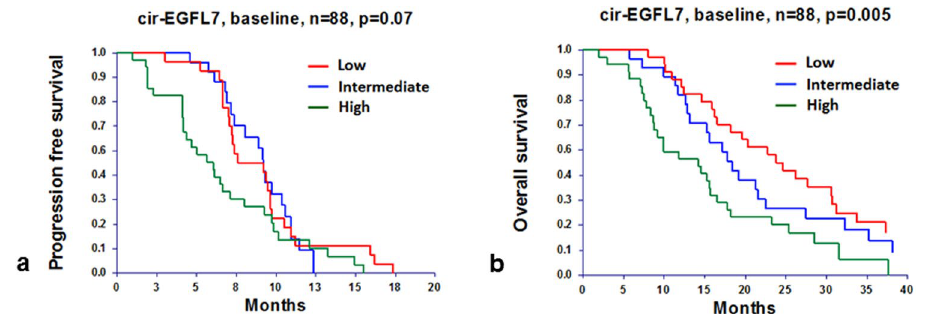
Figure 2. Progression free ( a ) and overall ( b ) survival according to circulating epidermal growth factor-like domain 7 (cir-EGFL7) levels at